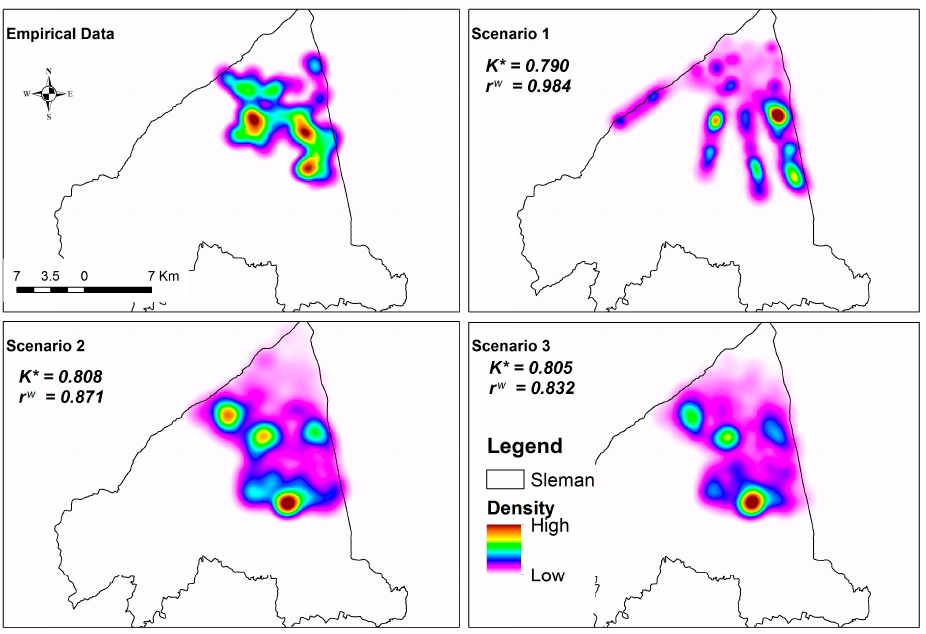
Figure 14. Overall comparison of spatial distribution of reluctant people. The scenario output was averaged.